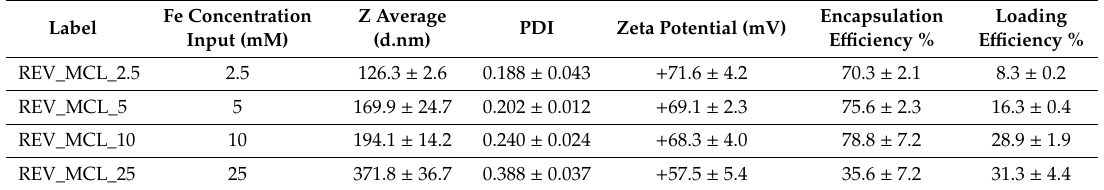
Table 2. Characterizations of magnetic cationic liposomes (MCLs) prepared by reverse phase